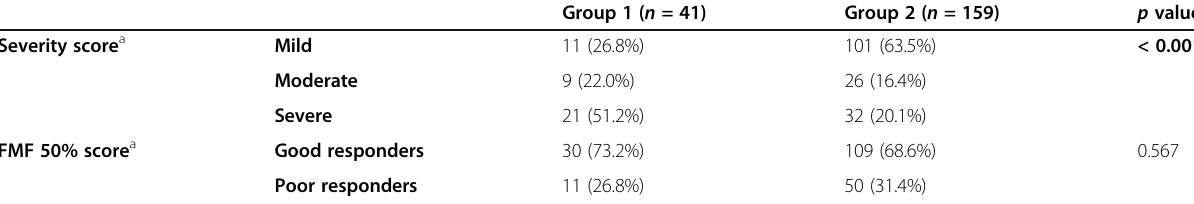
Table 6 Comparison between group 1 and group 2 patients as regards severity score, FMF 50% score